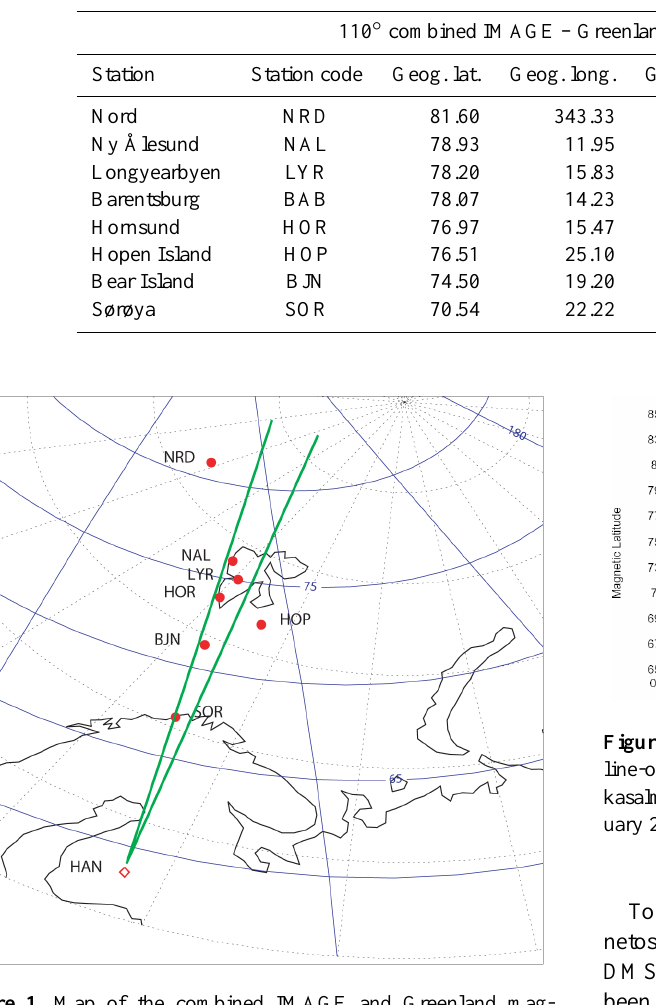
Figure 1. Map of the combined IMAGE and Greenland mag- netometer array. Beam no. 9 (green lines) of SuperDARN high- frequency (HF) radar in Hankasalmi (indicated by the open dia- mond) covers the Svalbard archipelago.